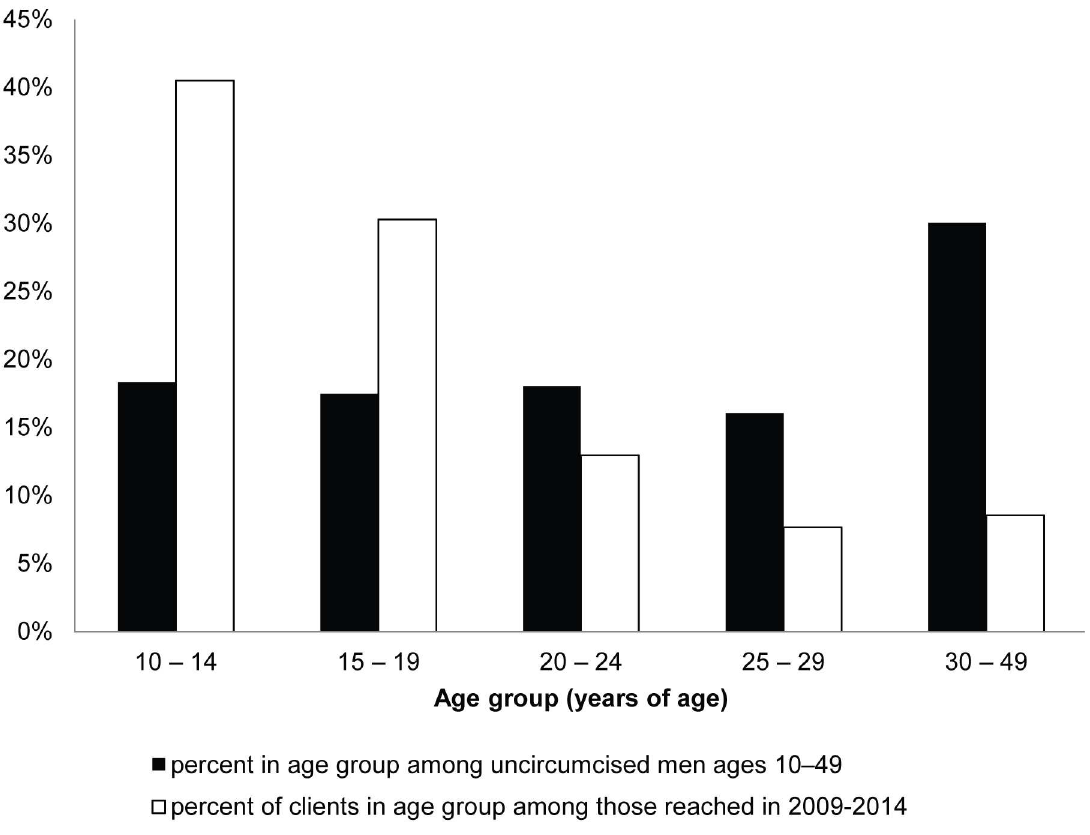
Fig 3. Age distribution of VMMC clients compared with the age distribution of potential clients. VMMC clients are shown in white bars; the age distribution of uncircumcised males in the overall populationof 10- to 49-year-old males (potential clients) is shown in black